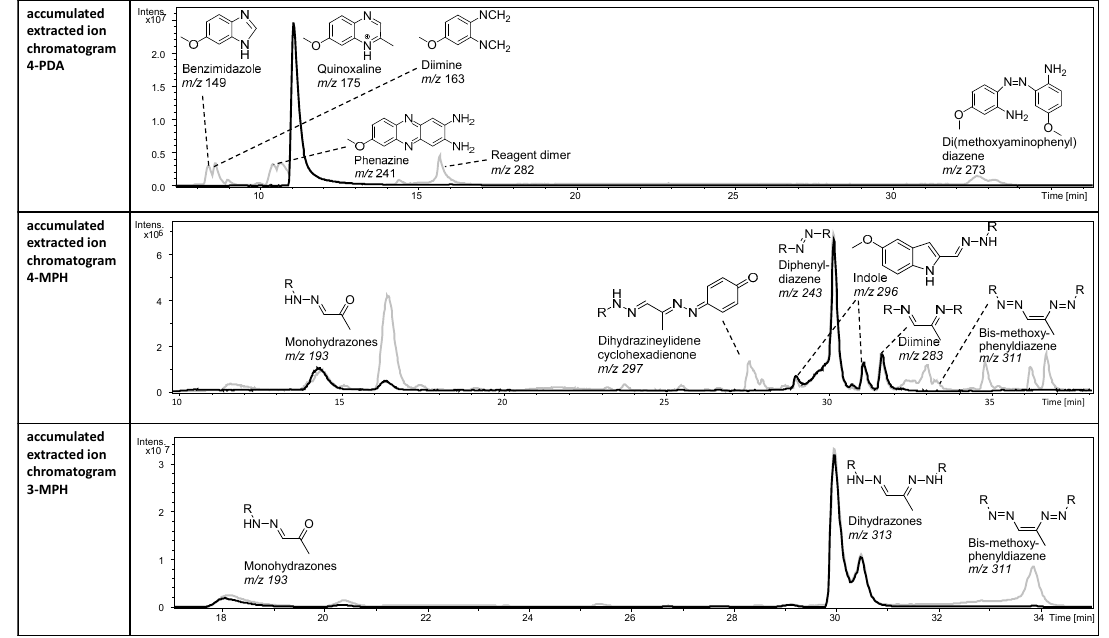
Figure 4. LC-ESI-MS analysis of reaction mixtures of methylglyoxal with phenylenediamines or phenylhydrazines. Top : reaction mixture with 4-PDA. Middle : reaction mixture with 4-MPH. Bottom : reaction mixture with 3-MPH. Black: ion current of selective mass traces, m/z 175 (extracted ion chromatogram for the reaction mixture with 4-PDA) or m/z 193, 243, 283, 296, 313 (reconstructed ion current for the reaction mixtures with 4-MPH and 3-MPH). Grey: base peak chromatogram, BPC (intensity of the base peak at a given retention time).